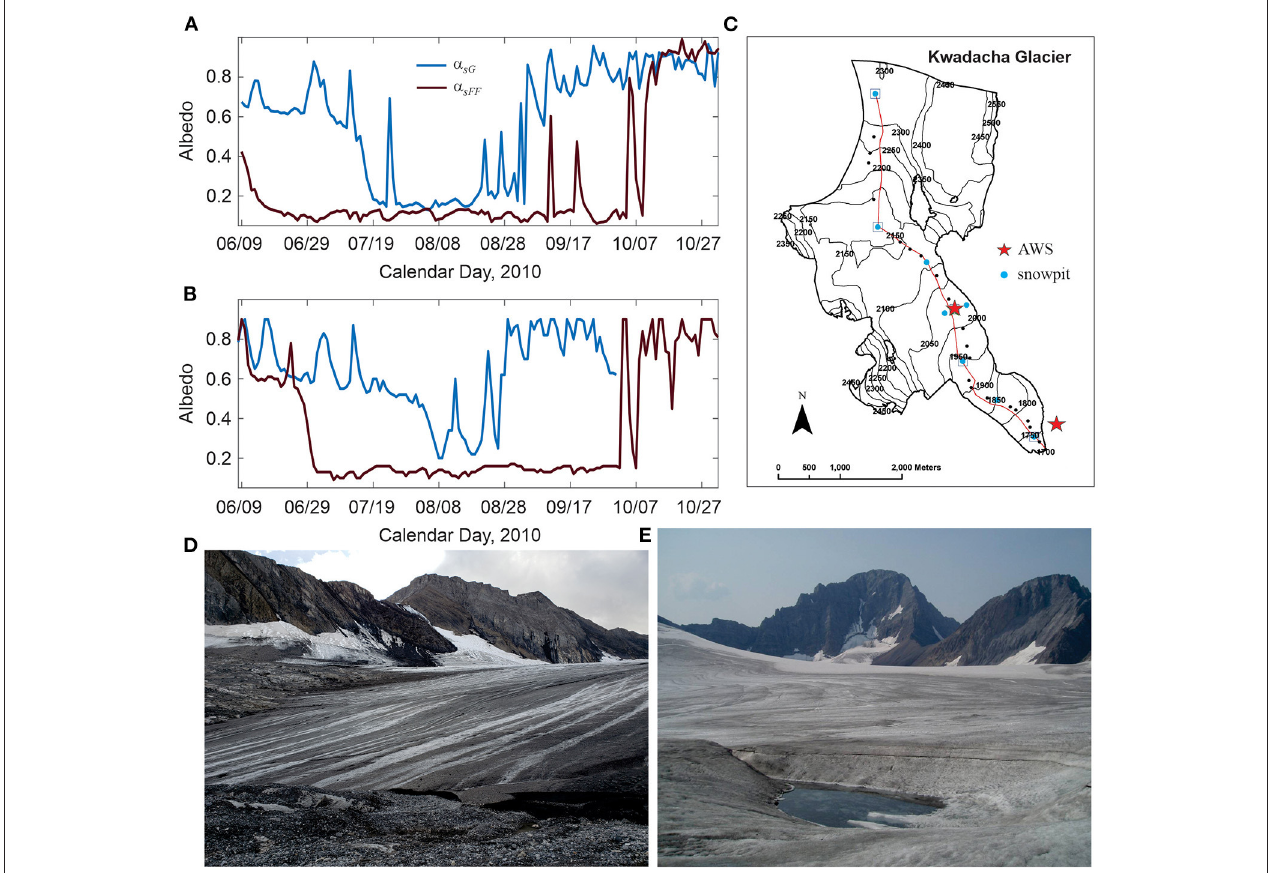
FIGURE 7 | Mean daily surface albedo through the summer melt season as measured by paired on- and off-glacier automatic weather stations at (A) Kwadacha and (B) Haig Glaciers in the Canadian Rockies. Both plots show the albedo evolution from June 8 to November 1, 2010 from glacier sites in the upper ablation area (blue) and from proglacial sites in the glacier forefields (brown). (C) Contour map of Kwadacha Glacier, with the stars indicating the AWS locations. Photographs (D,E) are August, 2021 and August, 2006 images of Haig Glacier, providing visual examples of exposed glacier ice with an albedo of ∼ 0.2 on the lower and upper glaciers. The end-of-summer seasonal snowline is visible in (E) . Photographs by the